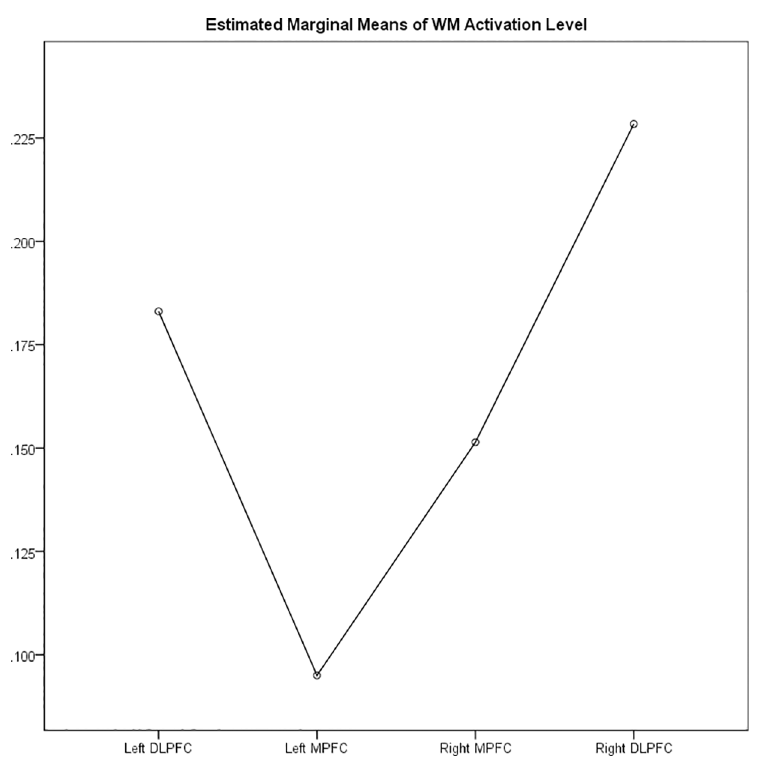
Fig 3. Estimated marginal means of WM activation level across all tasks in different PFC